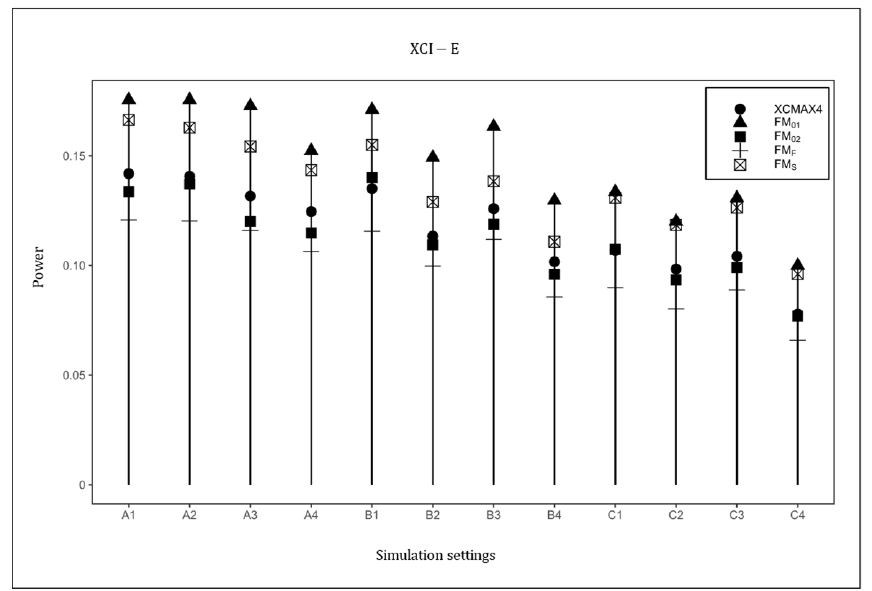
Figure 4. Powers of XCMAX4, FM 01 , FM 02 , FM F , and FM S under XCI-E. The simulation was based on 10,000 replicates with β = 0.15, α 1 = − 5, and F = 0. In the horizontal coordinates, “A”, “B”, and “C” represent three combinations of : ( 0.3,0.3 ) , ( 0.3,0.2 ) , and ( 0.2,0.3 ) , respectively, and the numbers 1–4 represent four combinations of ( α 2 , α 3 ) : ( 0.4055,0.5 ) , ( 0.4055,1.5 ) , ( − 0.4055, 0.5 ) , and ( − 0.4055,1.5 ) , respectively.